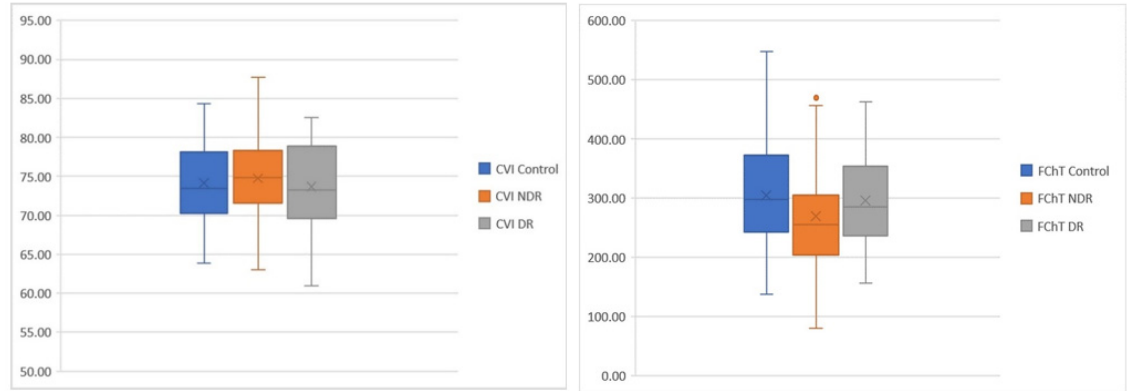
Figure 6. Blox plots. Differences among groups regarding CVI ( left ) and FChT (right ). In Table 5, the multiple regression model shows that increasing age is associated with a decreased CVI ( p = 0.002). In univariate and multivariate regression, male gender was significantly associated with an increased CVI ( p = 0.03). There were no statistically significant associations between CVI and other factors. Table 5. Linear regression analyses of systemic and ocular factors associated with CVI. Univariate Multivariate a Unstandardized β Standardized β p -Value Unstandardized β Standardized